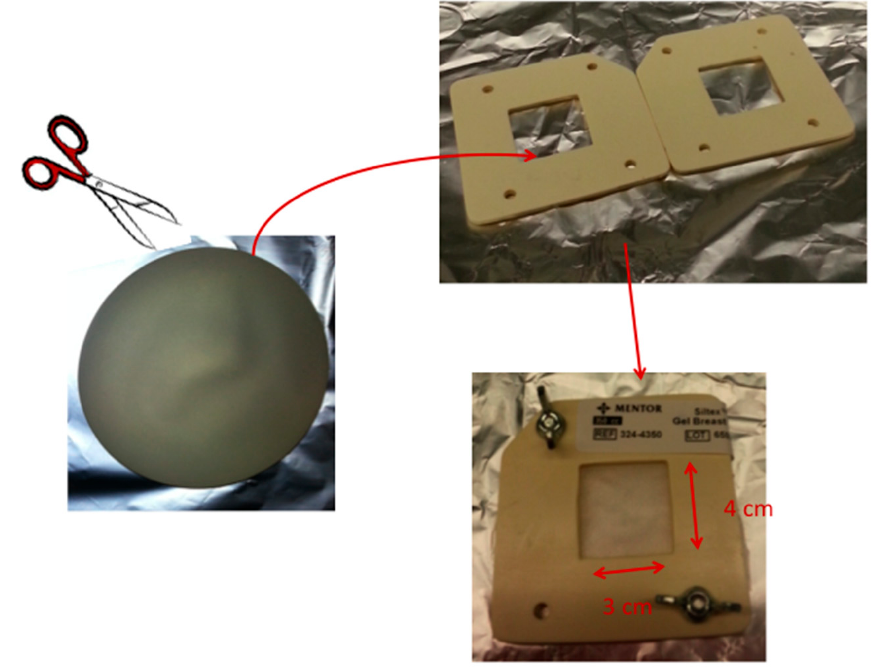
Figure 3. Scheme of sample preparation for proteomics analysis.